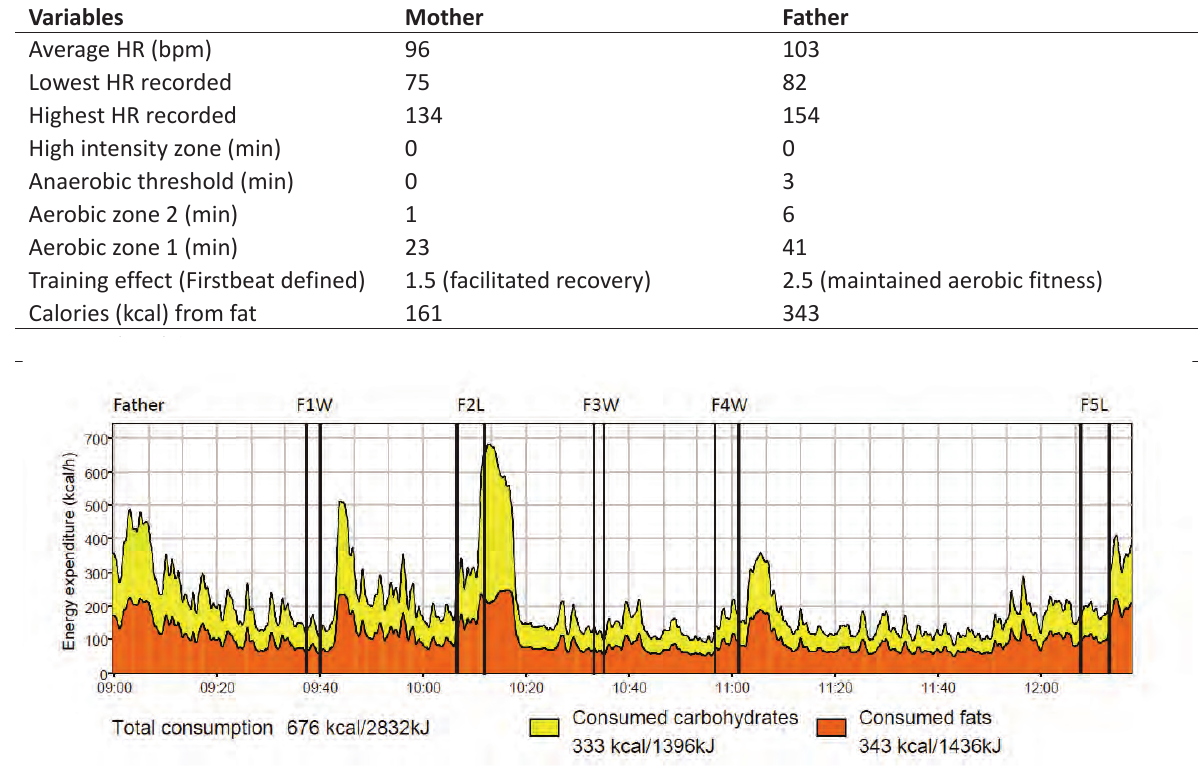
Table 1. Descriptive data for time before, during, and immediately after competition for each parent